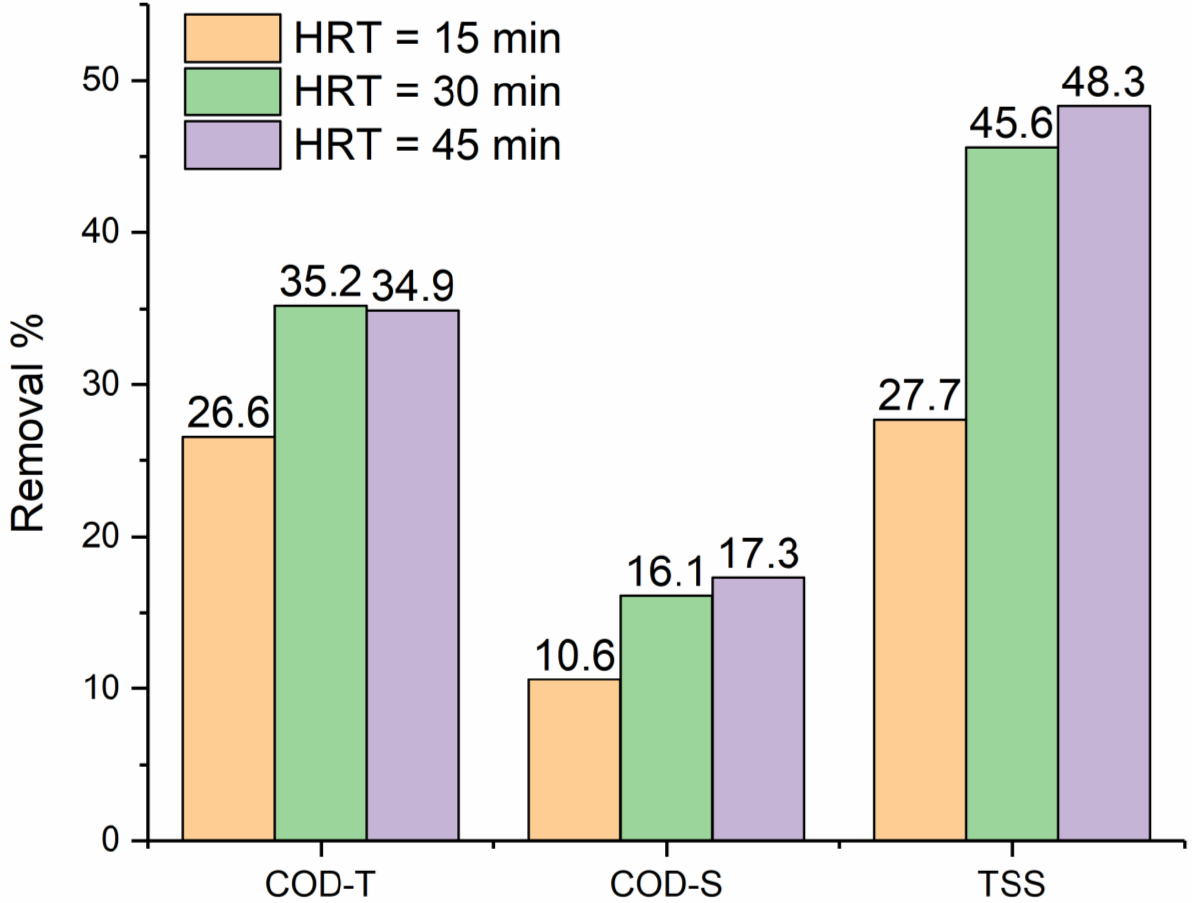
Figure 3. Effect of HRT on performance of pilot-scale BEPT process in terms of COD-T, COD-S and TSS removal.